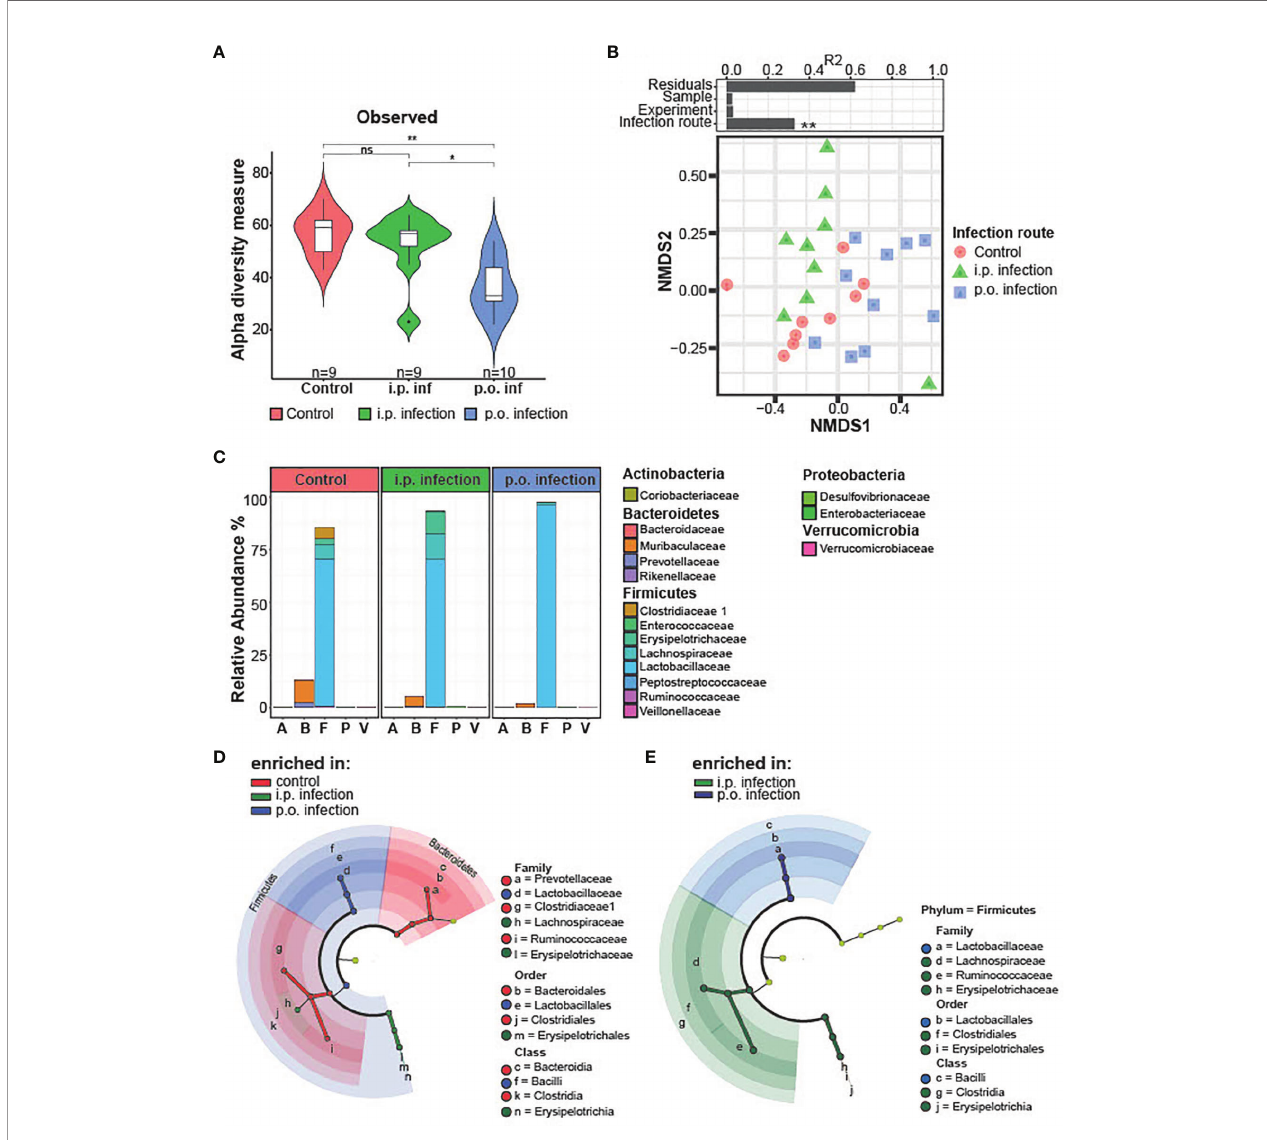
FIGURE 3 | Microbiota composition on day 28 post-infection i.p. vs. p.o. challenge. Small intestinal microbiota was analyzed using 16S rRNA gene sequencing after 28 days of oral and intraperitoneal T. gondii infection. Analyzed samples (n=9/group and time point) had a minimum sequencing depth of 1000 reads and a mean sequencing depth of 24,946.4 reads. (A) Alpha diversity in control and orally infected mice was determined using Chao1 and Shannon index. P-values indicated represent a Mann-Whitney U test comparison between groups with ns, non-signi fi cant, **p<0.01. (B) Non-metric multidimensional scaling (NMDS) ordination analysis of small intestinal microbiota composition was performed using Bray – Curtis distances. Individual effect size of tested covariates is indicated. To calculate the variance explained by individual factors such as sample, experiment or group a permutational multivariate analysis of variance (ADONIS) was used. *p<0.05. A signi fi cant effect was dedicated when p<0.05 and R2>0.10 (equivalent to 10% of explained variance). (C) Relative abundance of the average microbiome composition was determined at the family level. Phylum and families are indicated. (D) Statistically signi fi cant differences on family levels in small intestinal microbiota composition between control and orally infected mice or (E) orally and i.p. infected mice. Data were analyzed using linear discriminant analysis (LDA) effect size (LEfSe) method (Kruskal – Wallis test with p<0.05 and LDA